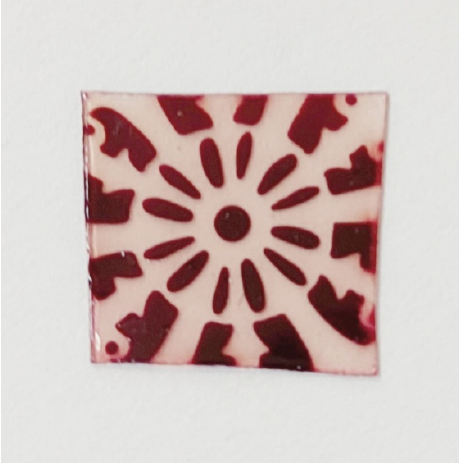
Figure 5. The sample after irradiation through the mask and further heating.